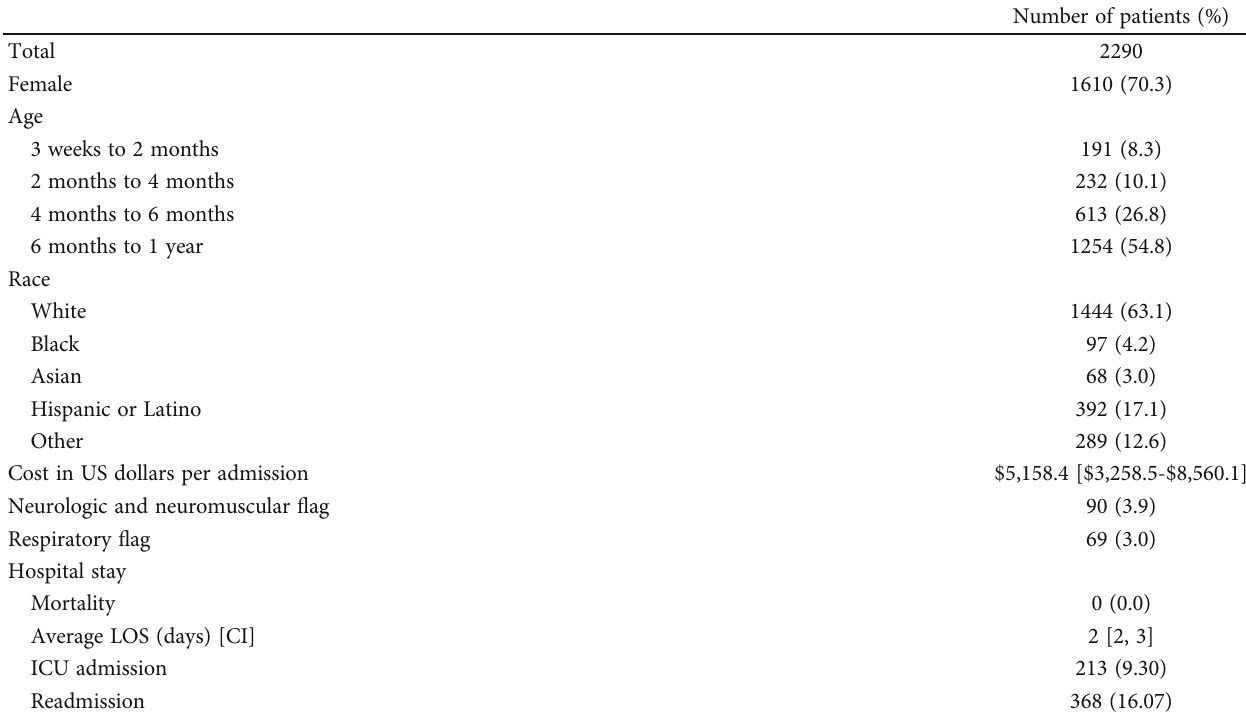
Table 1: Demographics and hospital stay characteristics for infantile hemangioma admissions.